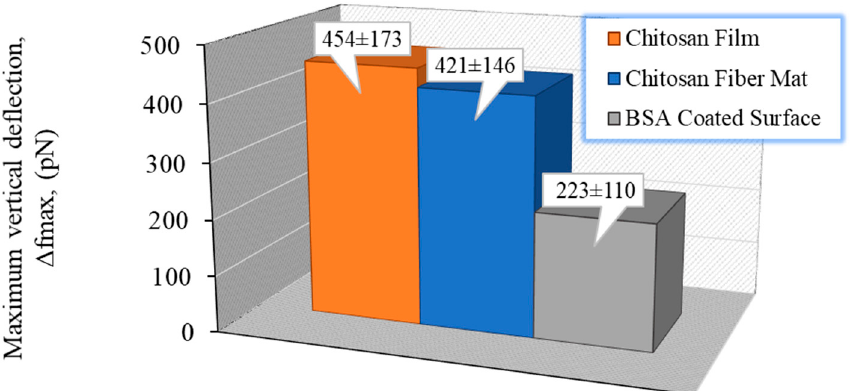
Figure 6. Distribution of maximum vertical force ( ∆ f max ) for the two substrates studied—chitosan film and chitosan nanofibers compared to the reference BSA-coated surface (significant difference found, p < 0.01), for a contact time of 60 s. Values presented as mean ± SD.